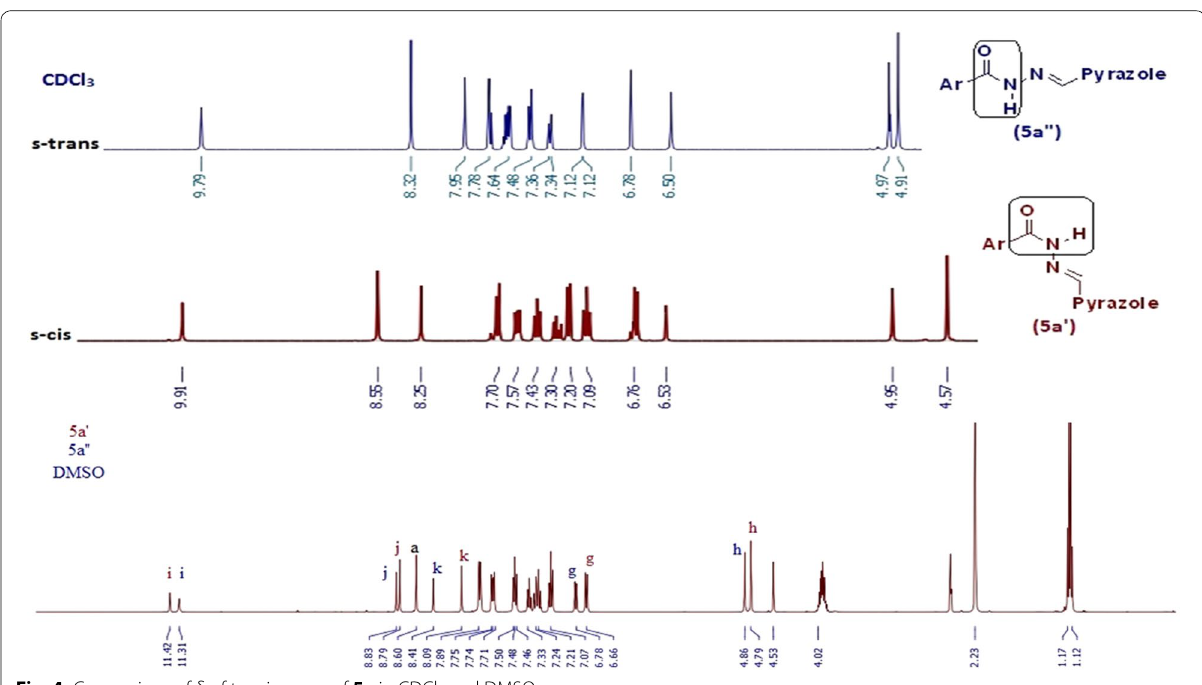
Fig. 4 Comparison of δ of two isomers of 5a in CDCl 3 and DMSO